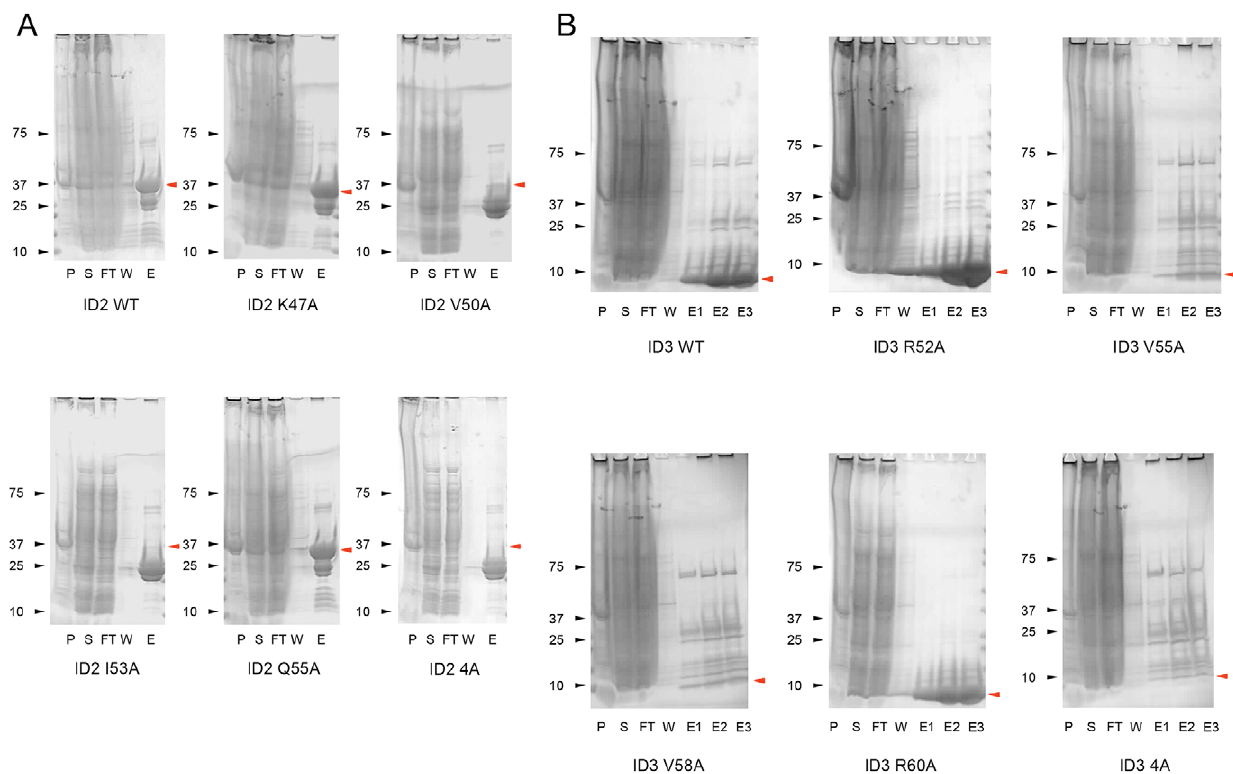
Figure 3. Protein expression profiles of ID2 and ID3 loop mutants in E.coli . ID2 (A) and ID3 (B) ion loop interacting amino acids were systematically mutated to alanine and the expression levels observed by SDS PAGE. 4A = all 4 amino acids simultaneously mutated to alanine. The rough molecular weight of the ID2-HisGST polypeptide is 37 kDa, while the ID2-His polypeptide is under 10 kDa, and their relevant sizes are indicated by the red arrows. Figure legend: P = Pellet, S = Supernatant, FT = Flowthrough from affinity column, E1, E2, E3 = Eluates from the affinity column.